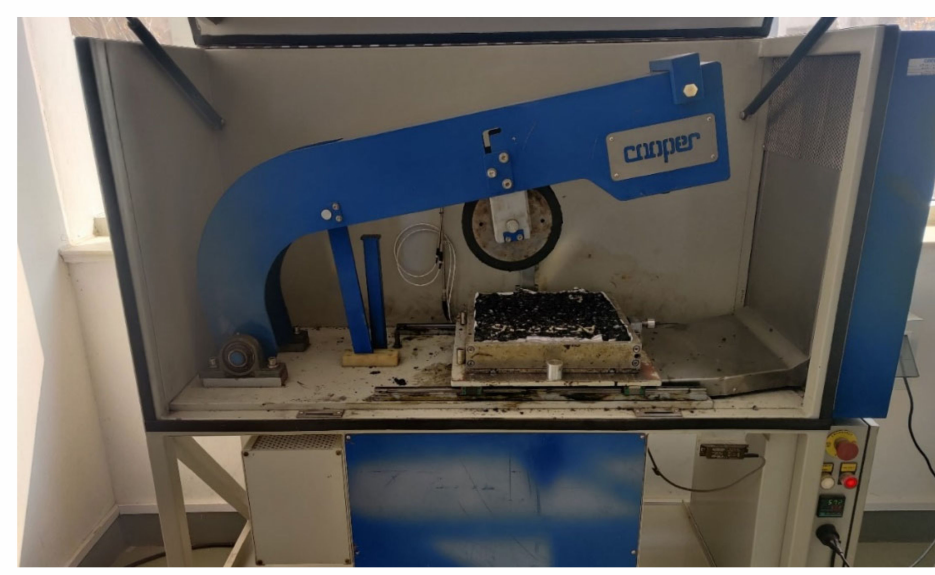
Figure 12. Wheel tracking